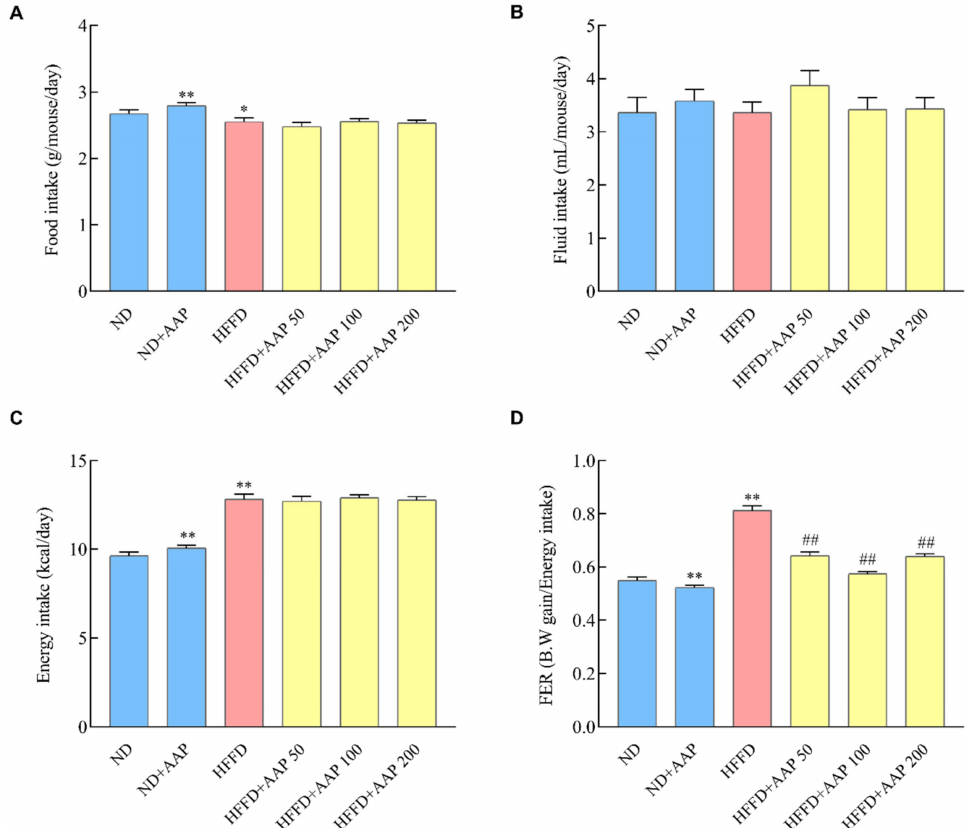
Figure 2. Effects of Auricularia auricula-judae polysaccharides on food intake and food efficiency ratio of mice. During the 12 weeks of mice rearing, the ( A ) food intake and ( B ) fluid intake of the mice were recorded every week. The calculated ( C ) energy intake and ( D ) food efficiency ratio of the mice. The data are presented as the mean ± SEM, * p < 0.05, ** p < 0.01, vs. ND group, ## p < 0.01 vs. HFFD